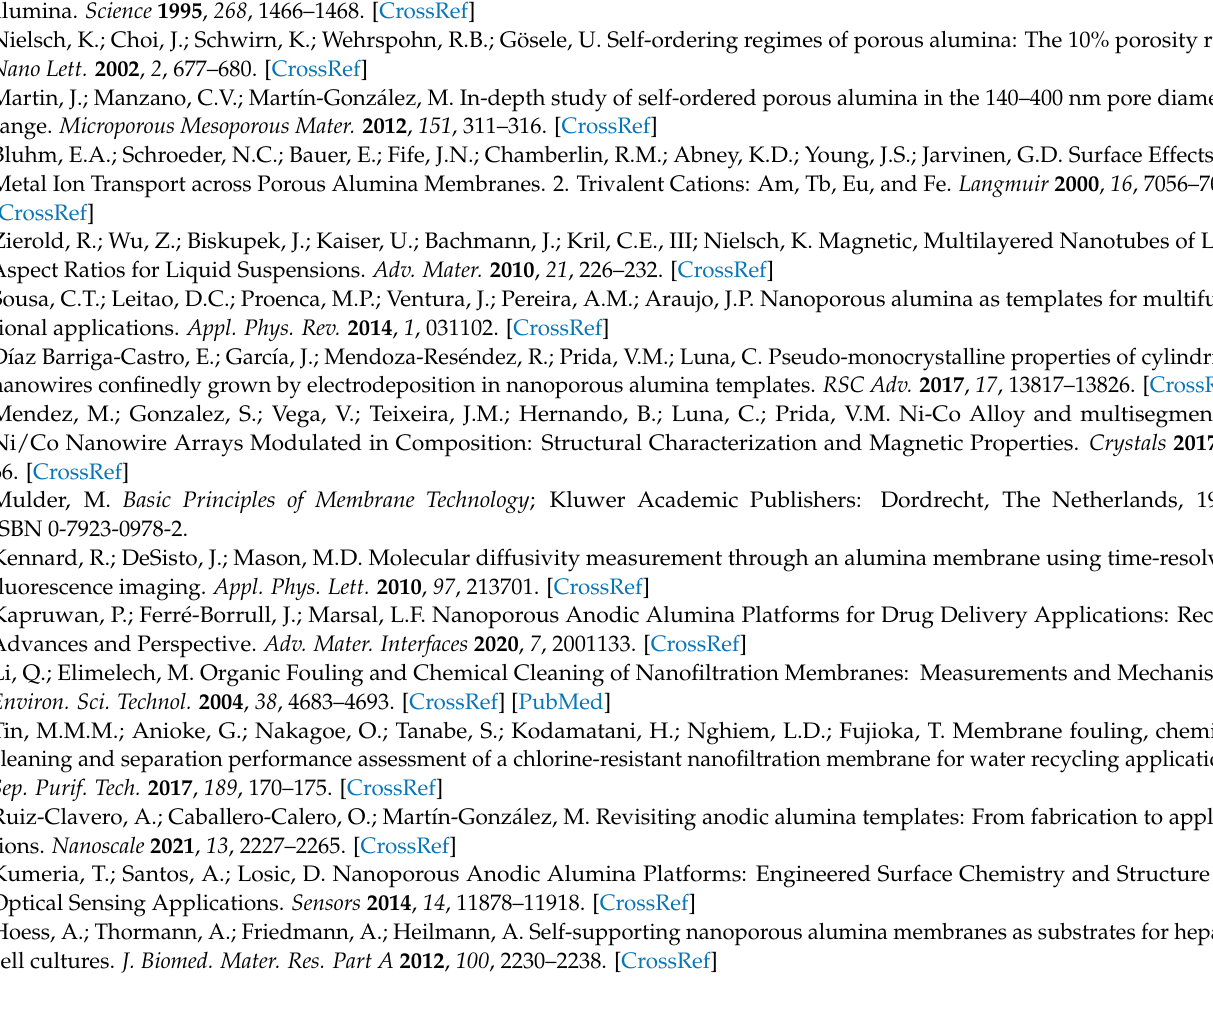
Ox-NPAM membrane surface. Figure S2: Scheme of electrochemical test-cell. Figure S3: Membrane potential vs. KCl solutions concentration ratio for samples: Sf-NPAM, Ox-NPAM, Sf-NPAM+TiO 2 and Ox-NPAM + TiO 2 membranes, ideal anion-exchange membrane (solid line, t Cl − = 1). Table S1: Atomic concentration percentages of the elements found on both surfaces of the studied samples Author Contributions: L.G. and J.B. performed electrochemical characterizations and A.L.C.